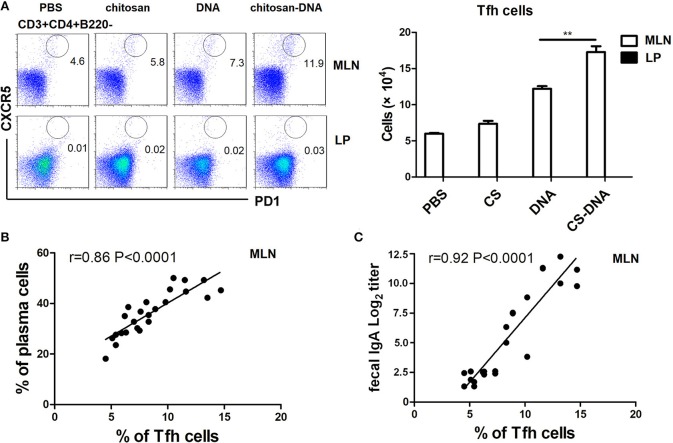
Intranasal chitosan-DNA increased Tfh differentiation in MLN, which correlated with IgA+ plasmablast frequency and IgA titer. (A) GALT MNC were stained with anti-mouse CD3, CD4, CXCR5, and PD-1 antibodies followed by flow cytometry. Within CD3+CD4+T cells, Tfh were identified as CXCR5high PD1high T cells. Absolute numbers of Tfh in MLNs and LPs of mice after chitosan-DNA immunization. Data present mean ± SEM of three independent experiments (n = 6). **P < 0.01. (B,C) Correlation of frequencies of MLN Tfh as determined by flow cytometry and MLN IgA+ Plasma cells (% of B cells) (B, r = 0.86, n = 6, P < 0.0001) or fecal IgA titer (C, r = 0.92, n = 6, p < 0.0001) is shown.